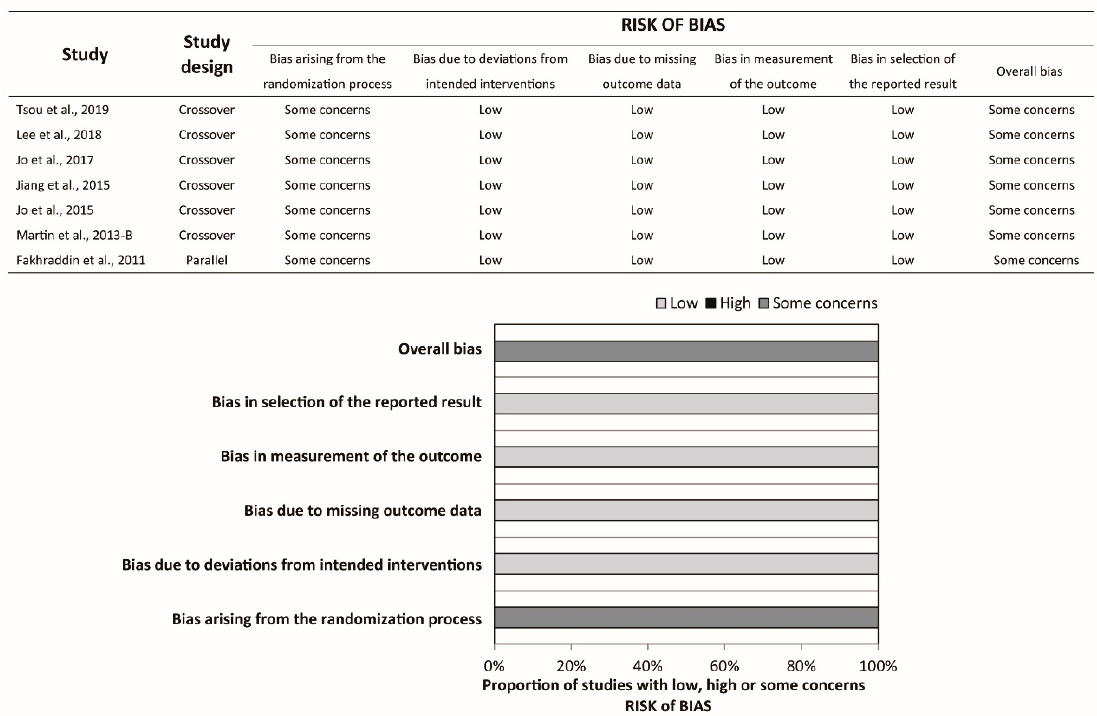
Figure 3. Risk of bias summary and graph of proportion of adequate compression depth.